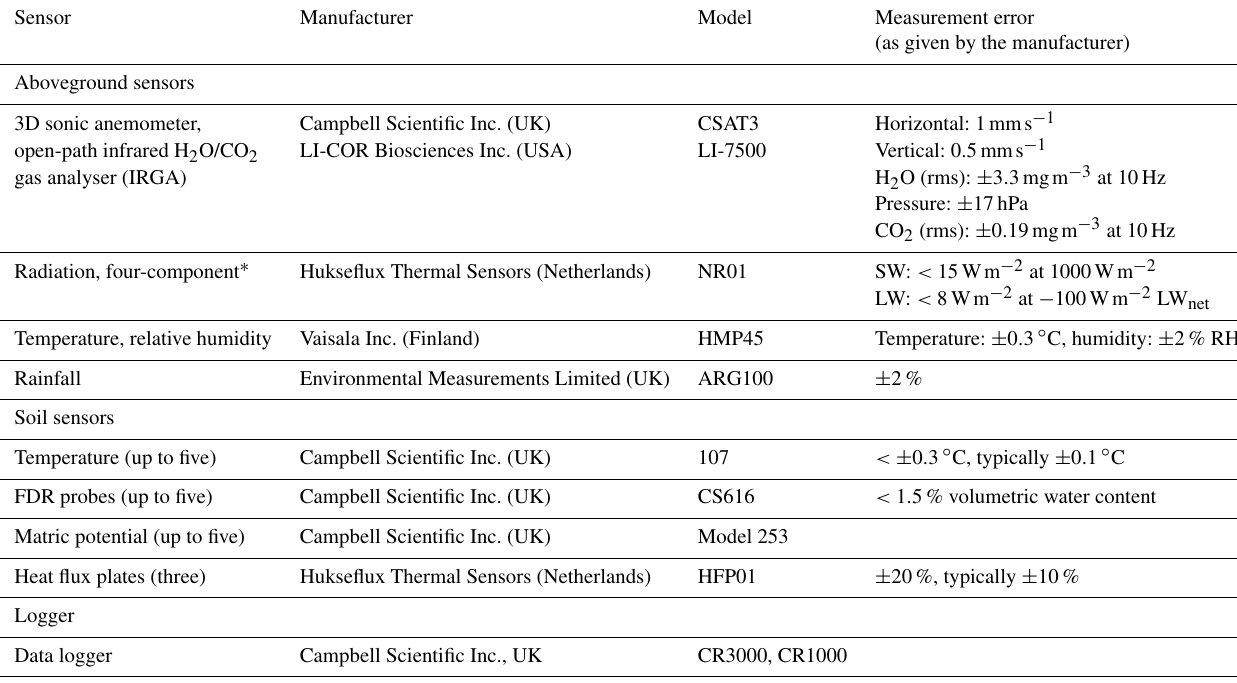
Table 4. The instrumentation of the eddy-covariance stations (Wizemann et al., 2015) used until 2018. Occasional changes to the general layout are detailed in the text.